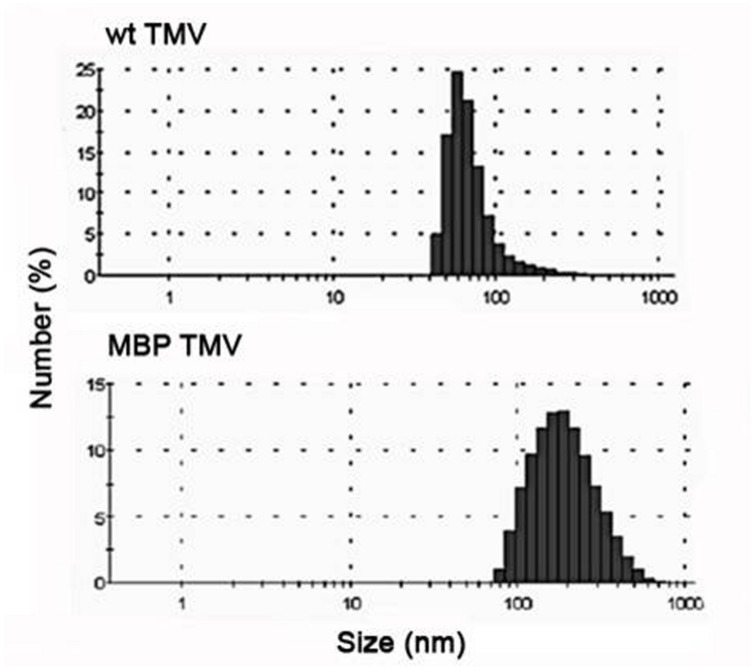
Dynamic light scattering (DLS) analysis showing the size distributions of wt TMV and MBP TMV. The size distributions reflect their aggregation state rather than the absolute hydrodynamic radius.